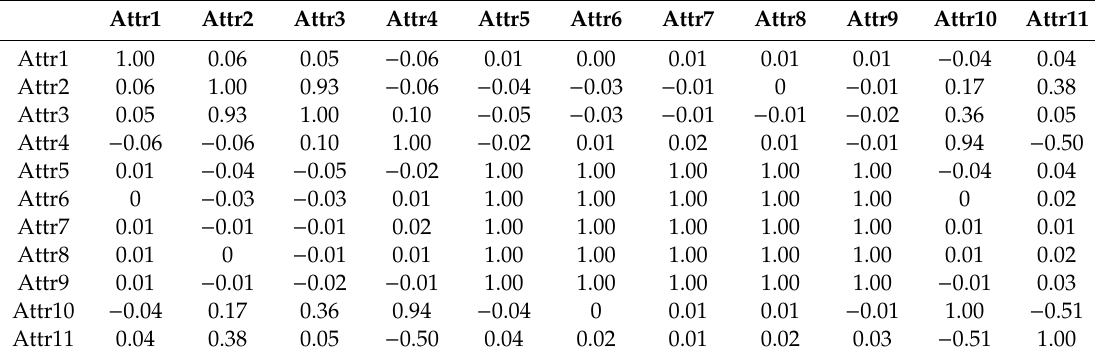
Table 4. Correlation coe ffi cient